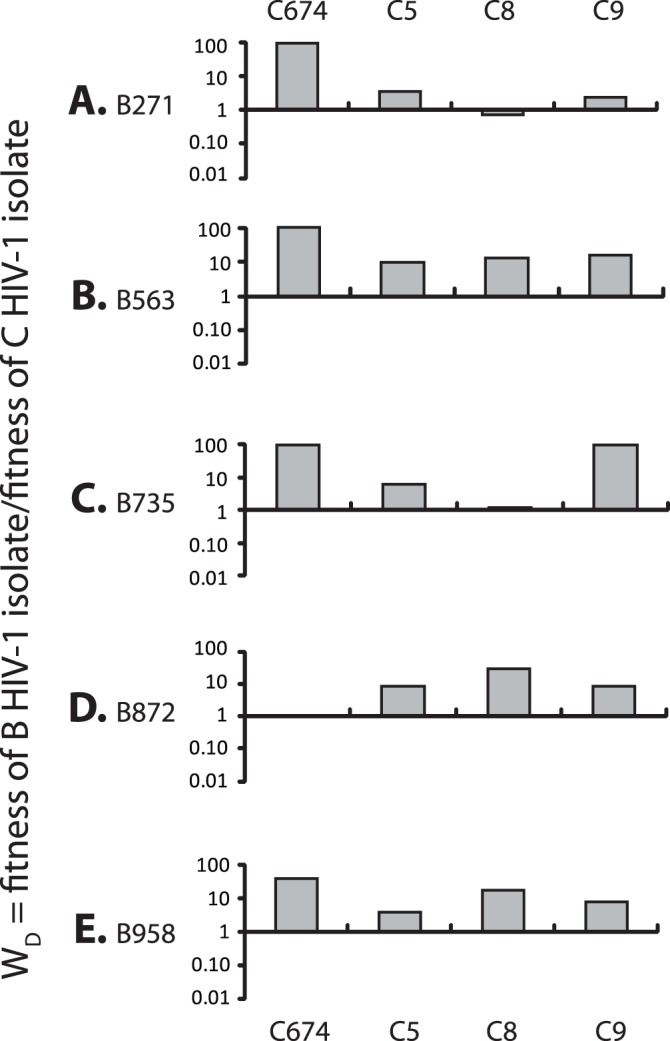
Relative fitness difference (WD) between Argentinean subtype B strains a) B271, b) B563 c) B735 d) B872, e) B958 and Subtype C strains C674 (Argentina), C5, C8, C9 (reference strains).Competitions were performed in PHA/IL2 treated PBMCs as in Figure 3. The fitness difference shown on the Y axis ranges from 0.01 to 100. Bars represent the fitness of the isolates shown on the Y-axis.